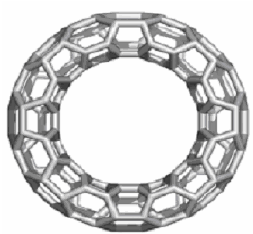
Figure 5. Three-dimensional graph of zig-zag polyhex nanotori.